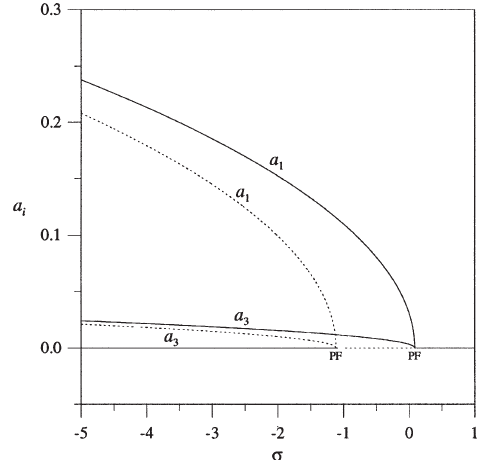
Fig. 9. Frequency-response curves for an additive-type external sub- combination resonance involving modes 1 and 3 for f = 50, (cid:22) 1 = 0 : 0137 and (cid:22) 3 = 0 : 076. Solid lines (—) denote stable fixed points and dashed lines (– – –) denote unstable fixed